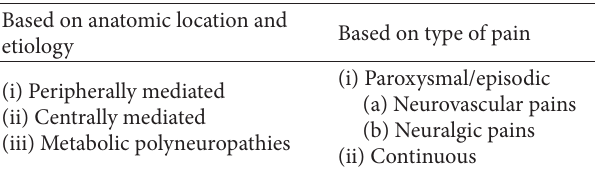
Figure 5: The photograph of the retrieved gutta-percha and silver points.